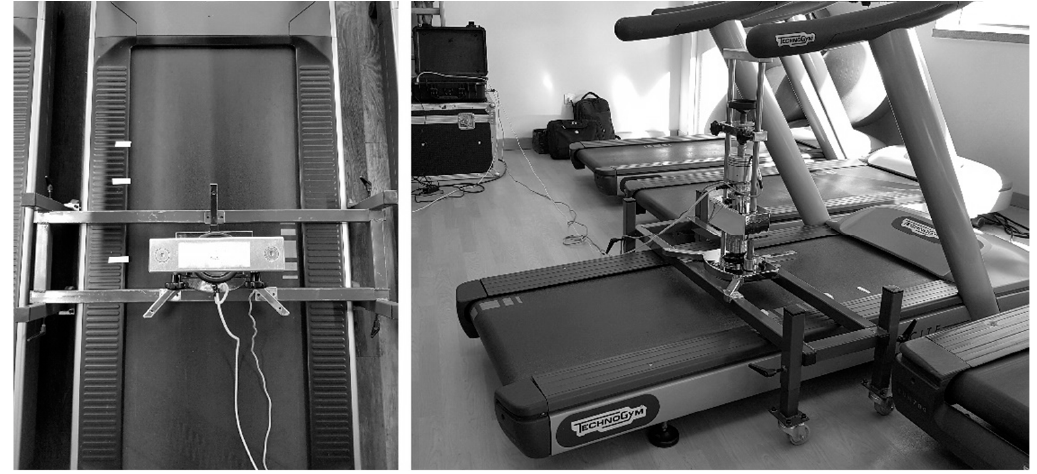
Figure 2. Test setup seen from above ( left ) and from the right rear side ( right ).